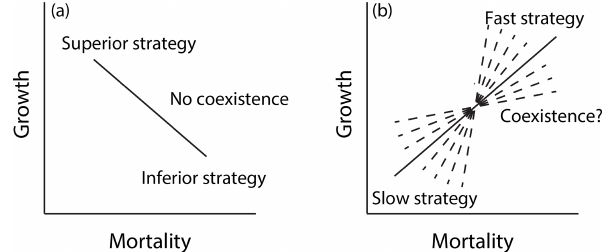
Figure 12. Growth–mortality trade-off and possible regimes of co- existence in a model like FATES along a successional axis. In a growth–mortality space, if a line connecting two PFTs comprising the system is negative as in (a) , one PFT should be competitively dominant and exclude the other. If the slope of the line is positive as in (b) , coexistence may be possible; however the range of slopes that may permit coexistence in tropical forests is not known a